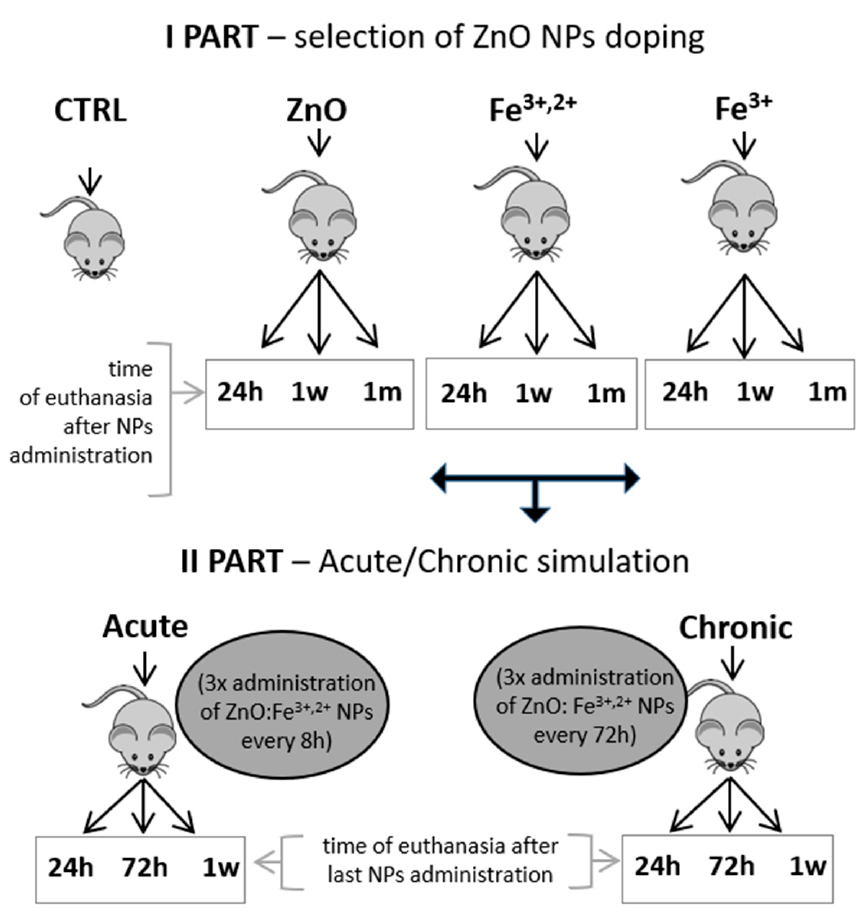
Figure 7. Schematics of animal study design (NPs—nanoparticles; 1 w—1 week; 1 m—1 month). Blood collected from all groups were analyzed for hematological parameters, level of serum ferritin and serum iron content (Figure 8). Erythrocyte count and hematocrit significantly increased in two Fe 3+,2+ groups at 24 h and one week after nanoparticle application (Figure 8a,f). In case of the red blood cell count (RBC), an increase was also detected in group ZnO:Fe 3+ one week following administration (Figure 8f). The level of hemoglobin was significantly increased in almost all experimental groups (except the ZnO nanoparticle group one month after application) (Figure 8b). Mean corpuscular hemoglobin (MCH), mean corpuscular hemoglobin concentration (MCHC), mean corpuscular volume (MCV) and red blood cell distribution width (RDW) did not significantly differ between experimental groups and control (Figure 8c–e,g). Both serum iron and ferritin levels did not show any significant changes within experiment (Figure